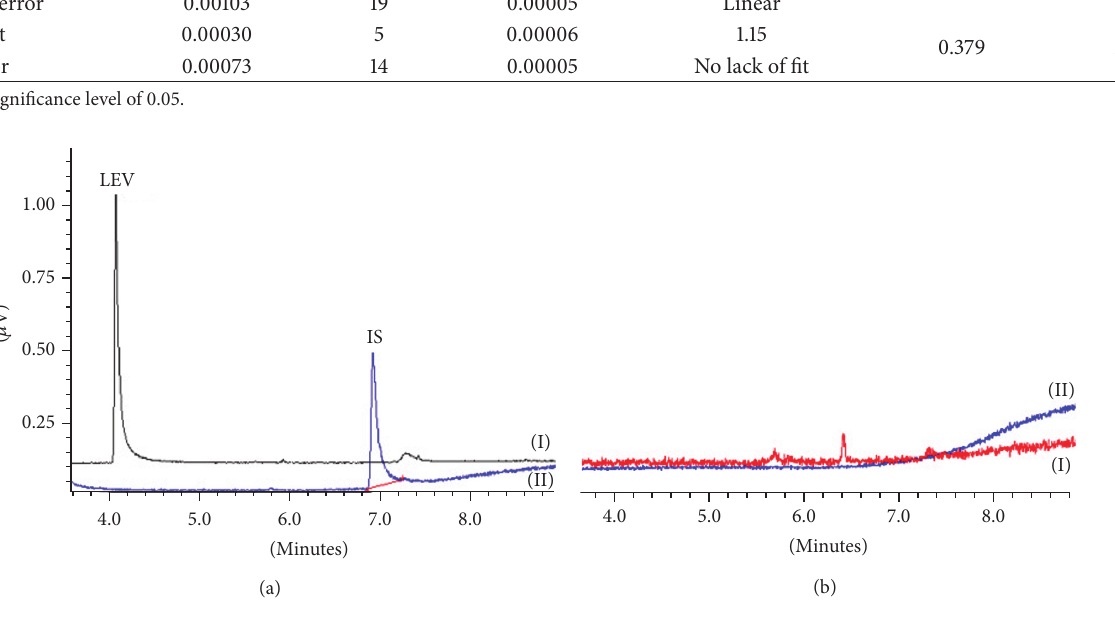
Figure 4: GC-MS chromatograms obtained from the analysis of an extracted patient plasma sample: (a) patient sample after the levetiracetam